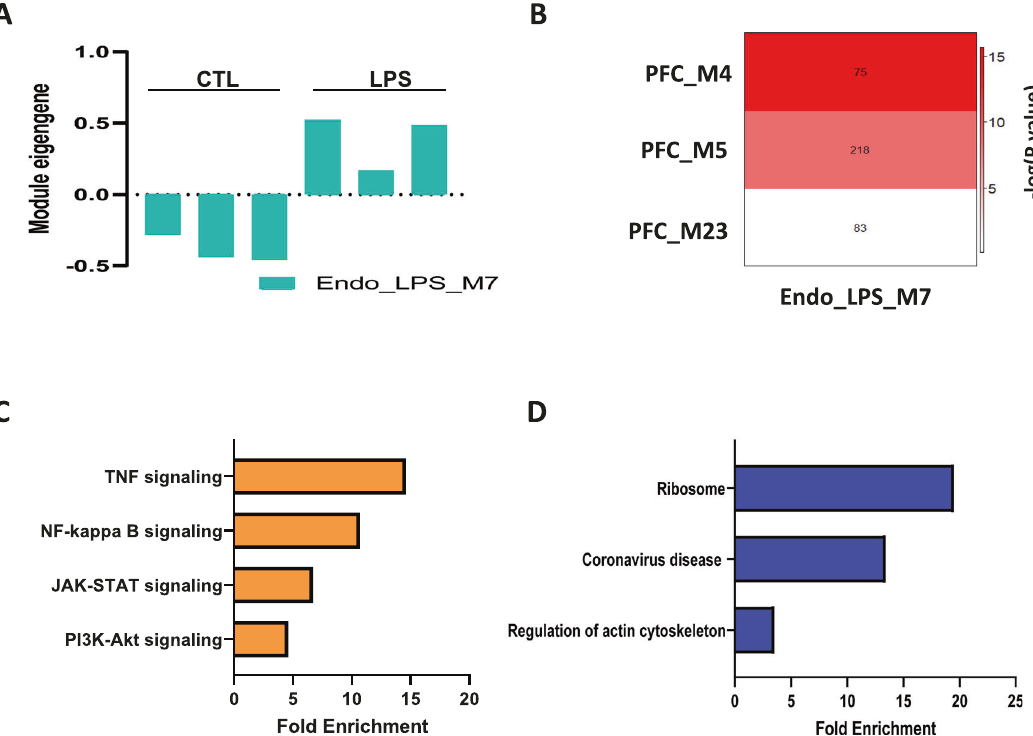
Fig. 5 Comparison of differentially expressed modules in the PFC of BPD to that from cerebral endothelial cells of mice treated with LPS. A The eigengene values of a differentially expressed module, Endo_LPS_M7 in the endothelial cells of mice treated with LPS for 2 h. B , Pairwise comparisons of the modules differentially expressed in BPD and the differentially expressed module in the endothelial cells. The color code of the heatmap encodes − log ( P value). The P -values were calculated by Fisher exact test for the overlapping of the two modules. The numbers in the heatmap indicate gene counts in the intersection of two modules. Major KEGG pathways signi fi cantly enriched in the genes common between PFC_M4 and Endo_LPS_M7 ( C ) and between PFC_M5 and Endo_LPS_M7 ( D